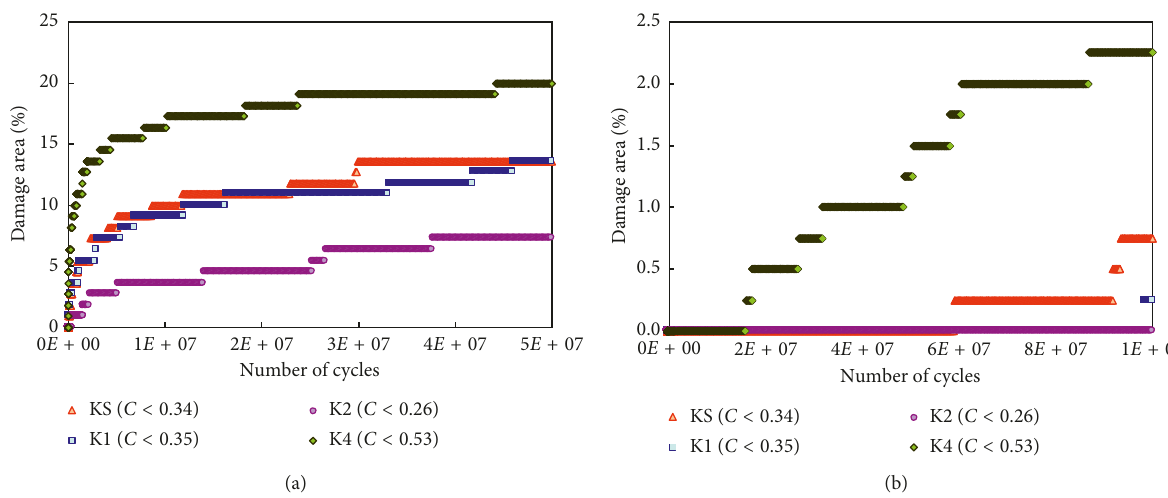
Figure 11: Modified damage area (%) along number of cycles for (a) thin pavement and (b) thick